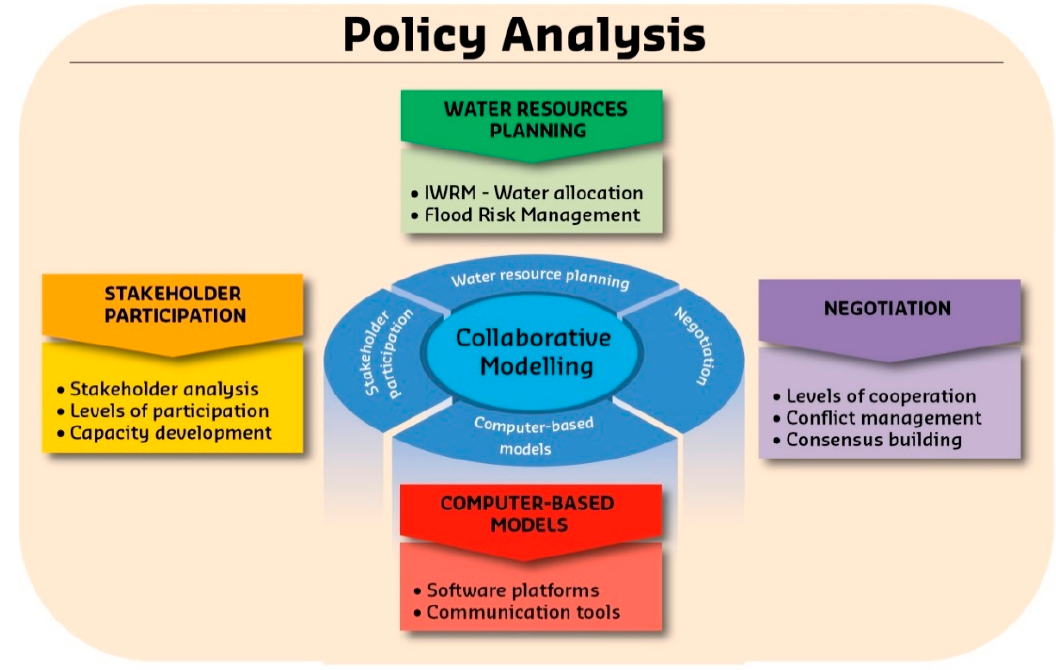
Figure 2. Collaborative modeling for policy analysis.